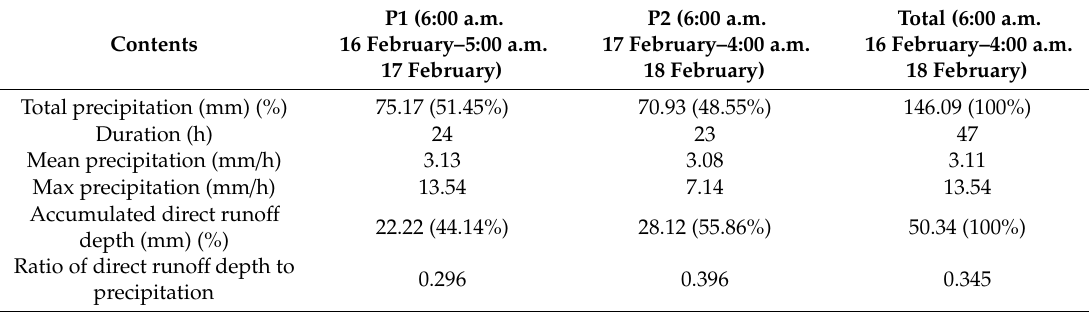
Table 5. Features of precipitation and direct runo ff depth for P1 and P2. The values are areal averages over the Russian river